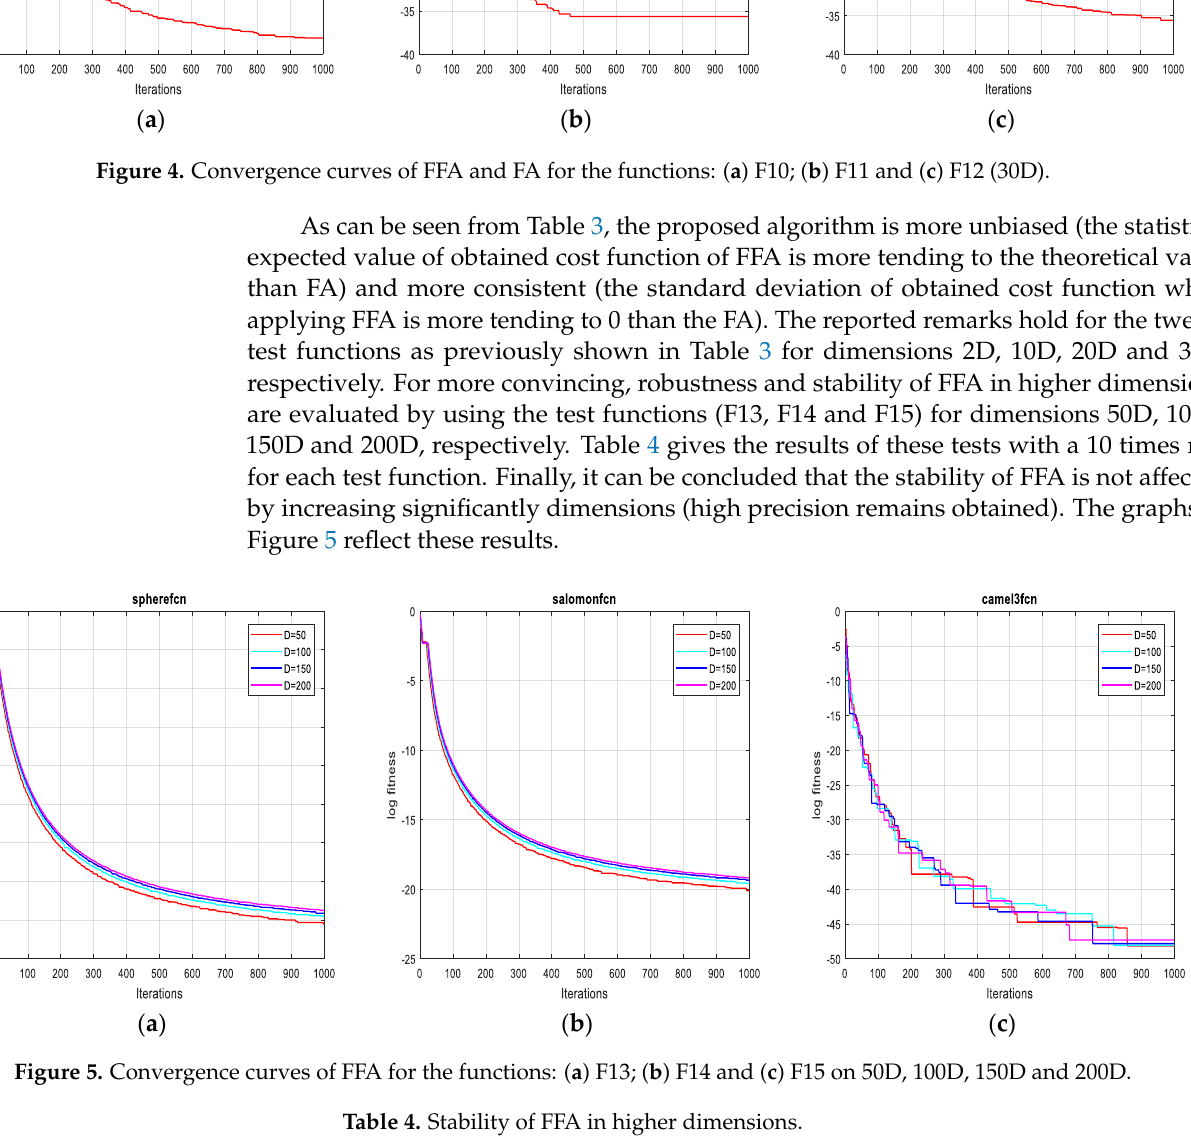
Table 4. Stability of FFA in higher dimensions. Figure 4. Convergence curves of FFA and FA for the functions: ( a ) F10; ( b ) F11 and ( c ) F12 (30D).